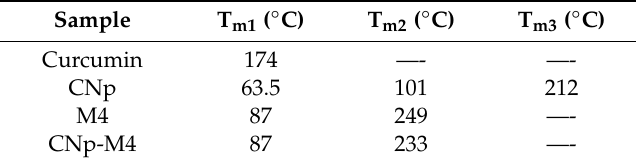
Table 2. Thermal events of curcumin, CNp, and alginate membranes by